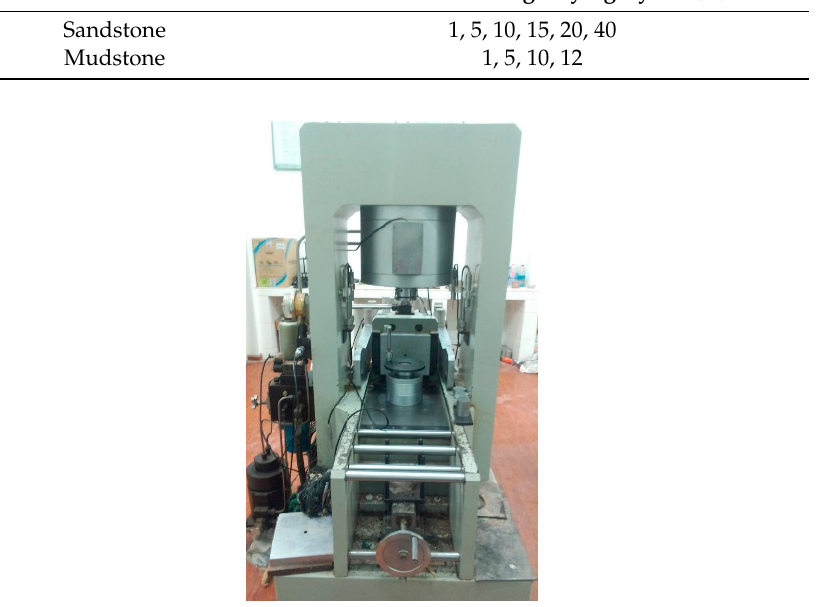
Figure 4. RMT-150C Rock mechanics testing system.